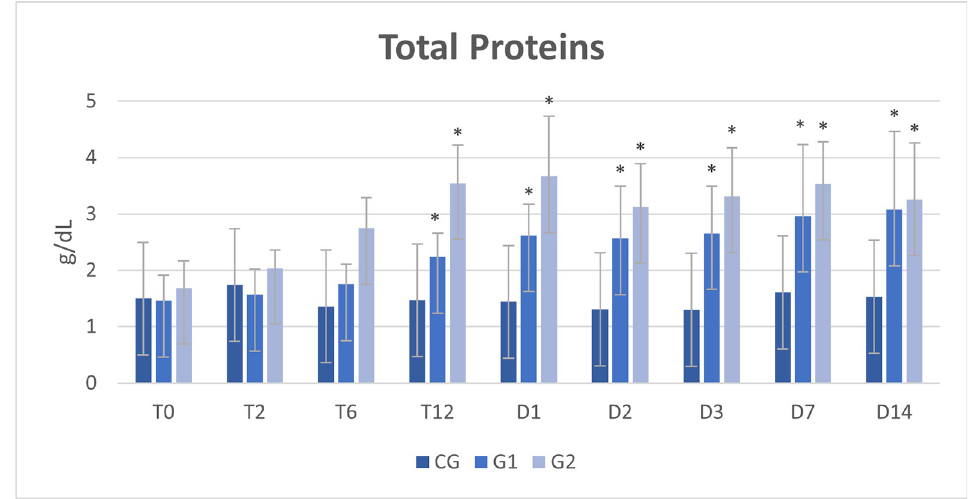
Table 7. Mean and standard deviation (SD) of alkaline phosphatase in the peritoneal fluid of healthy horses (CG) and horses submitted to cecal trocarization with a cecal needle (G1) or a cattle trocar (G2). Alkaline Phosphatase (mg/dL)